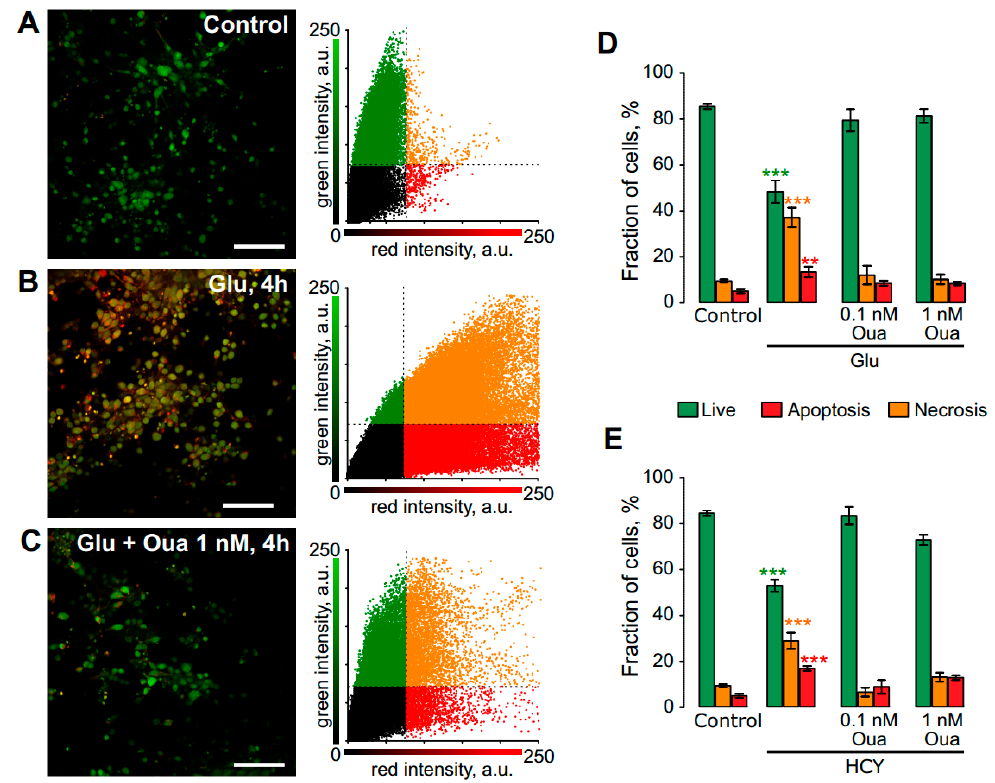
Figure 1. Neuroprotective effect of ouabain (Oua) against neurotoxicity induced by 4 h excitotoxic insults in rat cortical neurons. ( A – C ) Confocal images represent an overlay of those recorded in green and red spectral regions of rat cortical neurons after 4 h treatment with the bathing solution (control, panel A ), and 100 μ M glutamate + 30 μ M glycine (Glu, panel B ) and Glu with 1 nM ouabain (Oua, C ) obtained with the fluorescent viability assay. Scale bar, 100 μ m. The correlation plots shown on the right of corresponding images allow estimation of the cell viability (percentages of live, necrotic and apoptotic neurons). ( D ) Histogram quantitatively compares the data obtained in control ( n = 8) and in the presence Glu ( n = 7) along and with 0.1 nM ( n = 8) or 1 nM ( n = 9) ouabain (Oua). Experimental conditions are indicated below the plots. Green columns represent percentages of live, red—of necrotic and orange—of apoptotic neurons. Mean values ± SEM are plotted. Experimental conditions are indicated below the plots. ** ( p = 0.002), *** ( p = 0.0001)—data are significantly di ff erent from control by one-way ANOVA with Tukey’s post- hoc test. ( E ) Histogram quantitatively compares the data obtained in control ( n = 8) and in the presence of 100 µ M homocysteine + 30 µ M glycine (HCY, n = 6) and 0.1 ( n = 7) nM or 1 nM ( n = 8) ouabain (Oua). Mean values ± SEM are plotted. Experimental conditions are indicated below the plots. Green columns represent percentages of live, red of necrotic, and orange of apoptotic neurons. *** ( p = 0.0002)—data are significantly di ff erent from control by one-way ANOVA with Tukey’s post- hoc test, n =